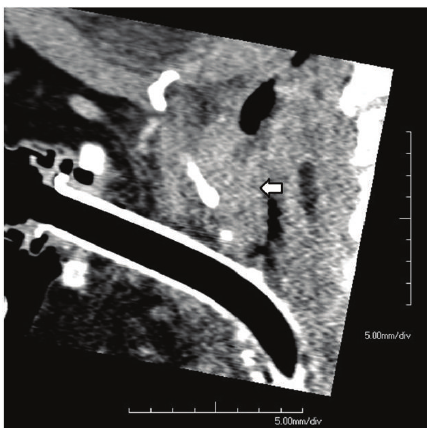
Figure 1: CT scan (sagittal image) of the neck with contrast per- formed after the initial tracheostomy demonstrates an ovoid mass (arrow) obstructing nearly the entire lumen of the airway. The mass measures 22 mm craniocaudally by 11mm anteroposteriorly.